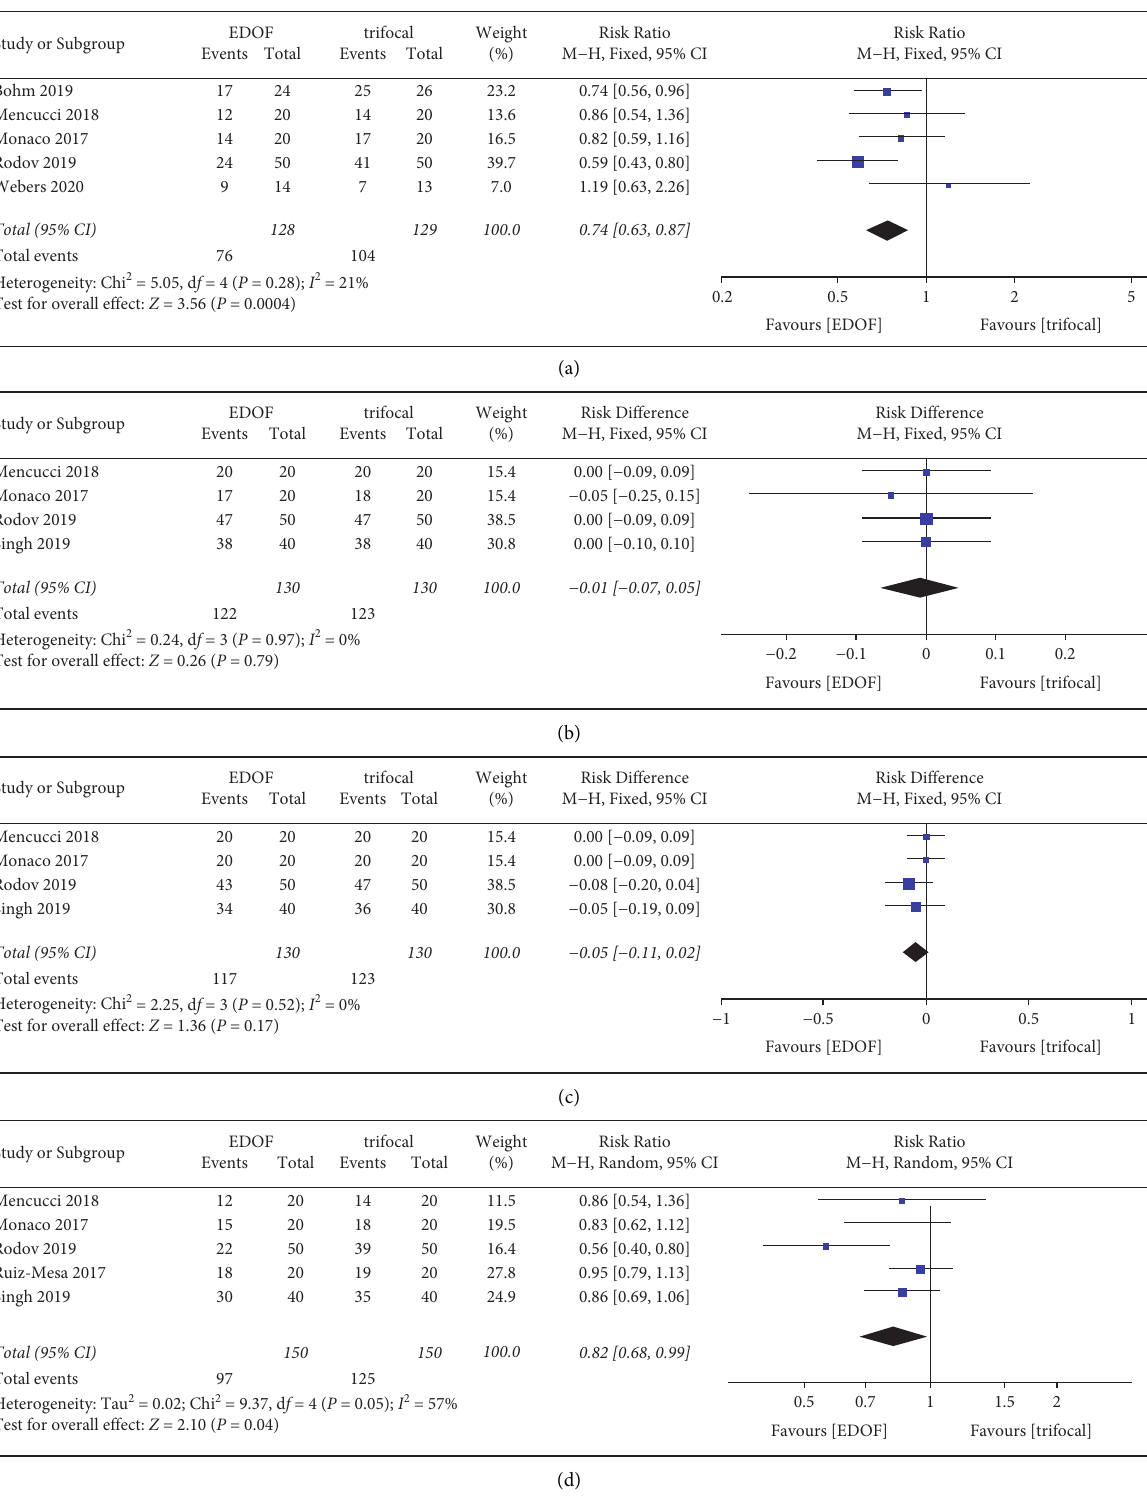
Figure 11: Forest plot of postoperative spectacle independence. (a) Total spectacle independence; (b) for distance vision; (c) for intermediate vision; and (d) for near vision. EDOF, extended depth-of-focus; CI, confidence